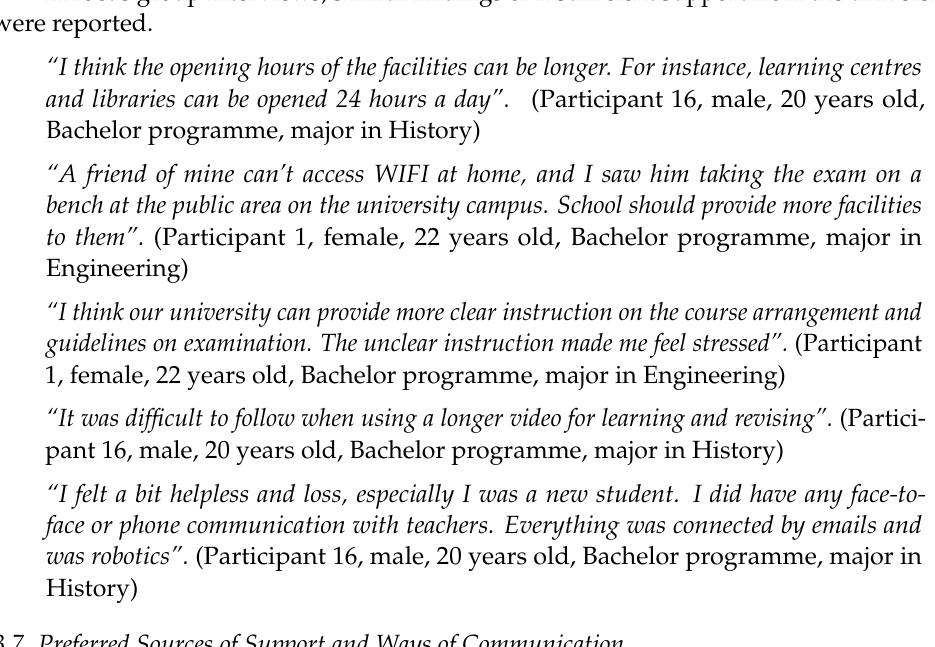
Figure 2. The preferred sources of support and ways of communication. ( a ) Preferred sources of support; ( b ) preferred ways of communication.